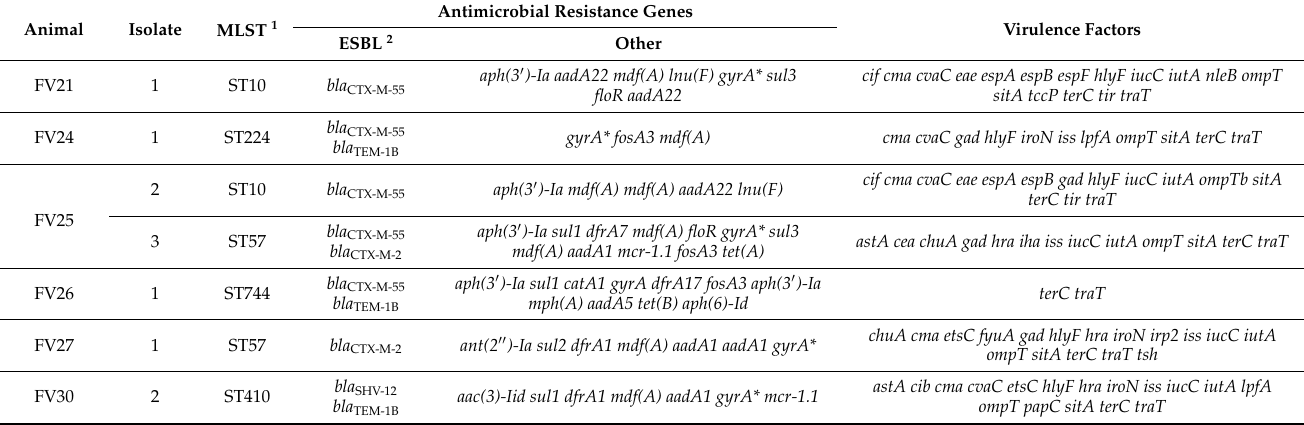
Table 3. Results of virulence factors and resistance gene detection and multilocus sequence typing (MLST) of the seven extended-spectrum beta-lactamase (ESBL)-positive E. coli isolates from six dogs fed raw meat-based diets in Brazil.